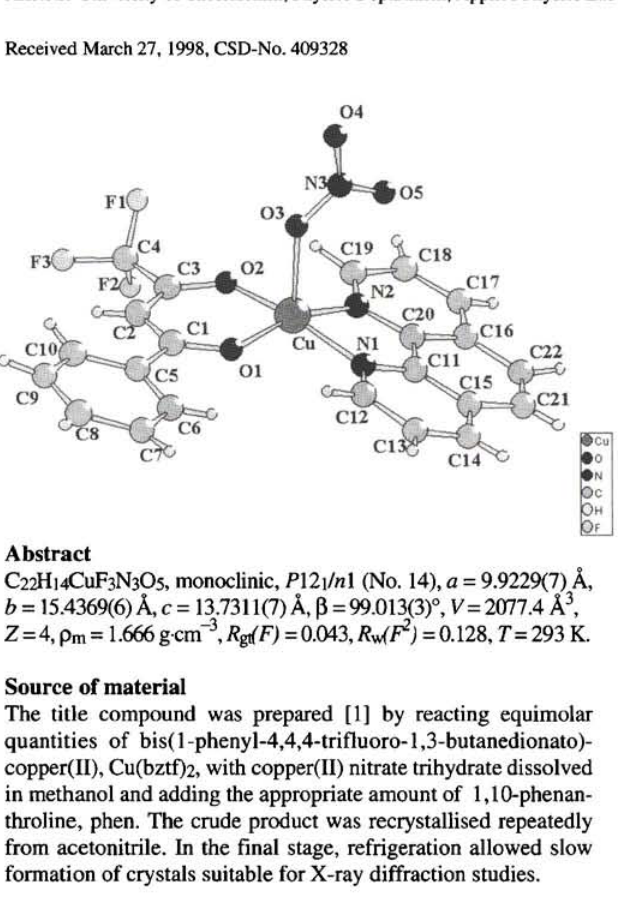
Table 2. Atomic coordinates and displacement parameters (in Â 2